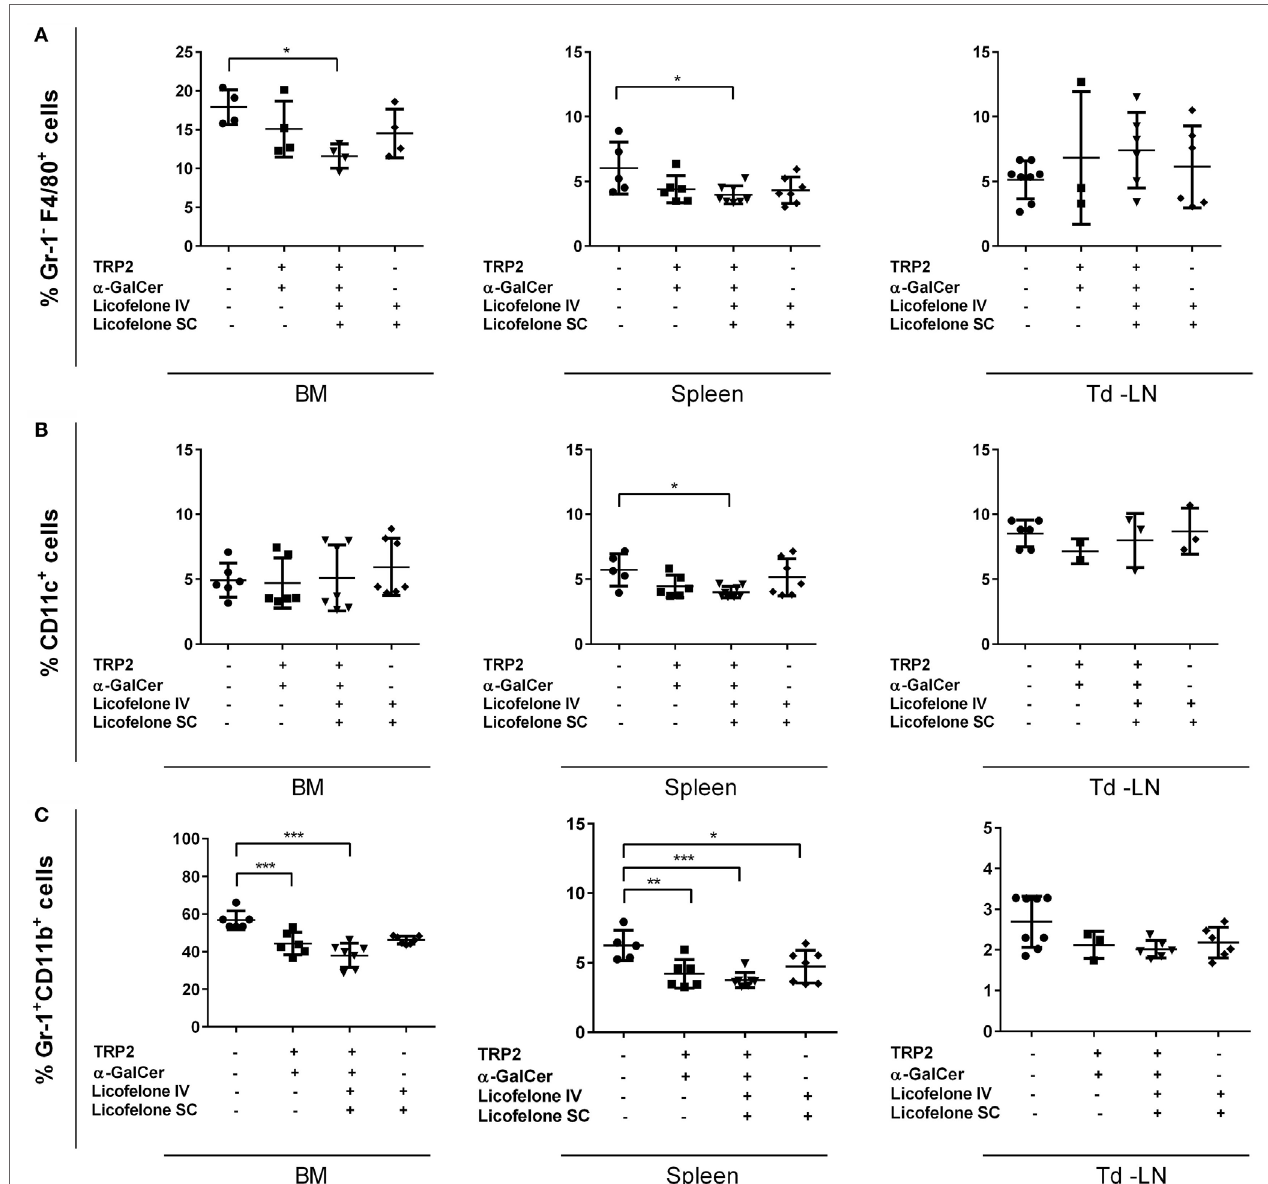
FigUre 2 | addition of licofelone to the vaccine therapy reduces the frequency of myeloid cell populations in the bM and the spleens of tumor- bearing mice . Mice were manipulated as described in Figure 1 and the BM, spleens, and td-LNs were collected on day 20 and analyzed for the frequency